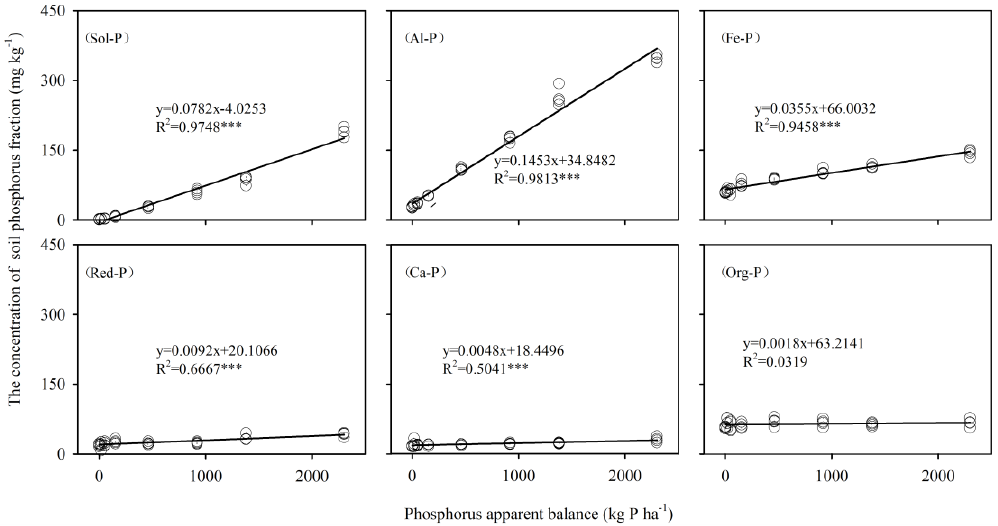
Figure 6. Relationship between PAB and soil P fractions in soil incubation. Note: *** means p < 0.001.